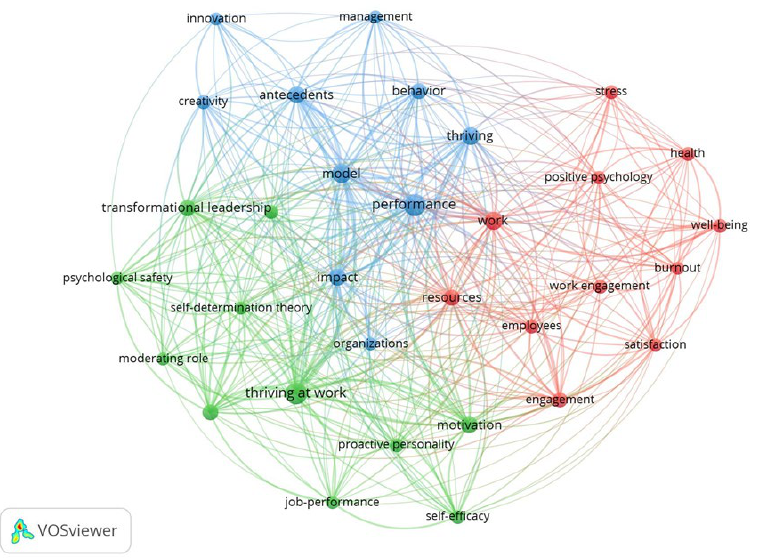
Figure 12. Mapping links between the most popular keywords conform to three clusters.